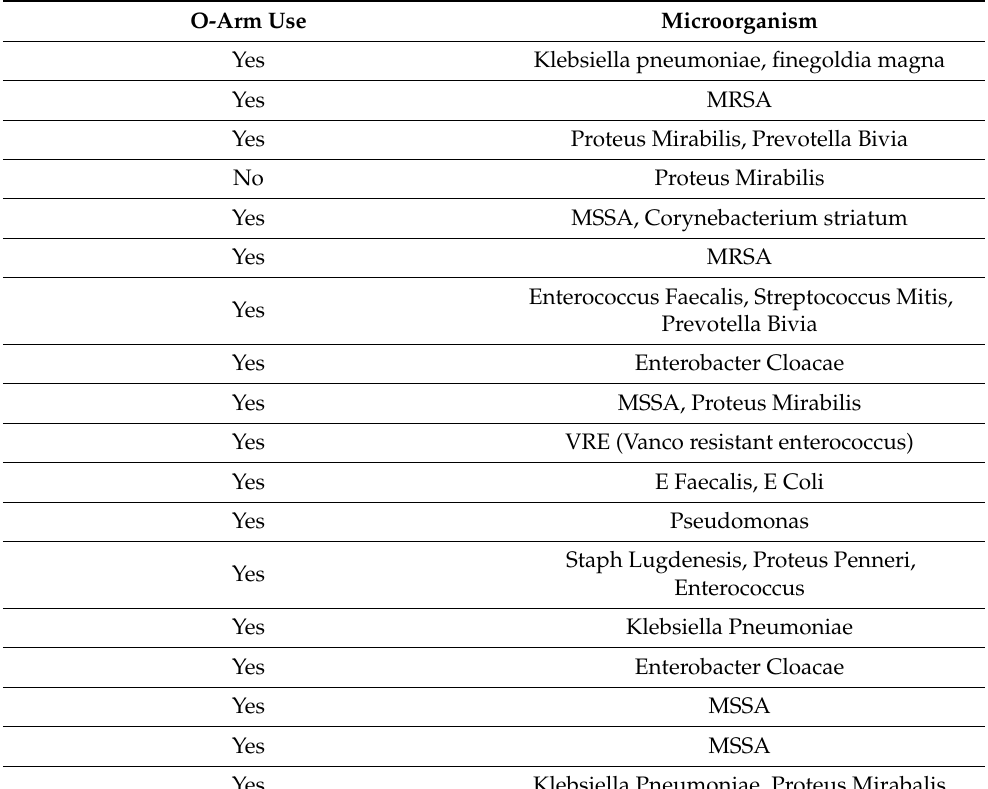
Table 2. Specific microorganisms identified based on intra-operative